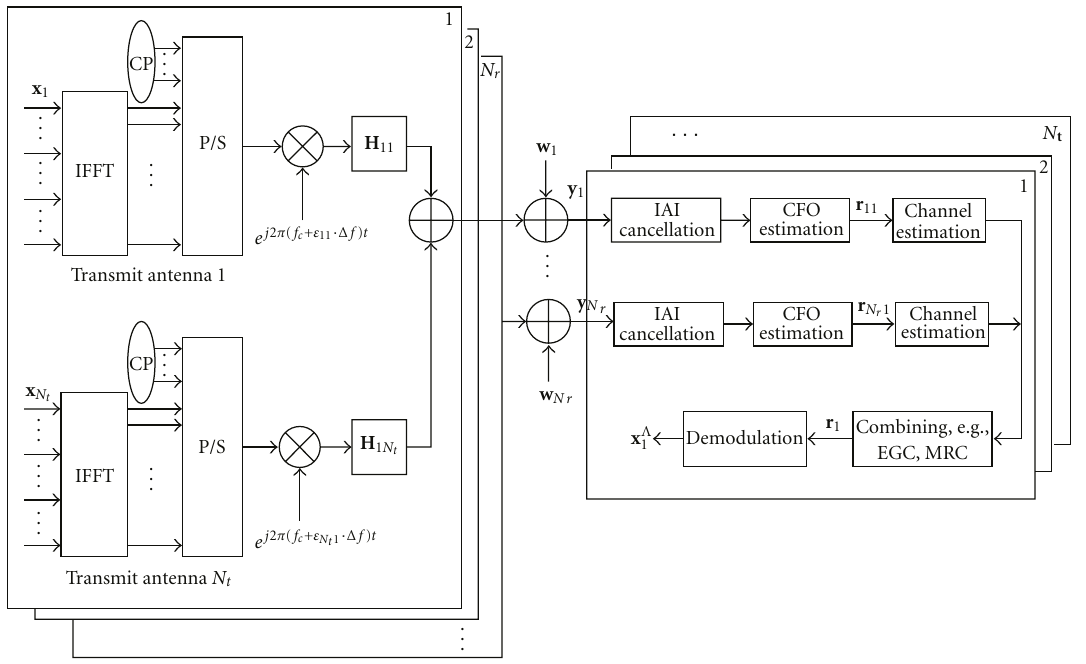
Figure 1: Structure of MIMO-OFDM